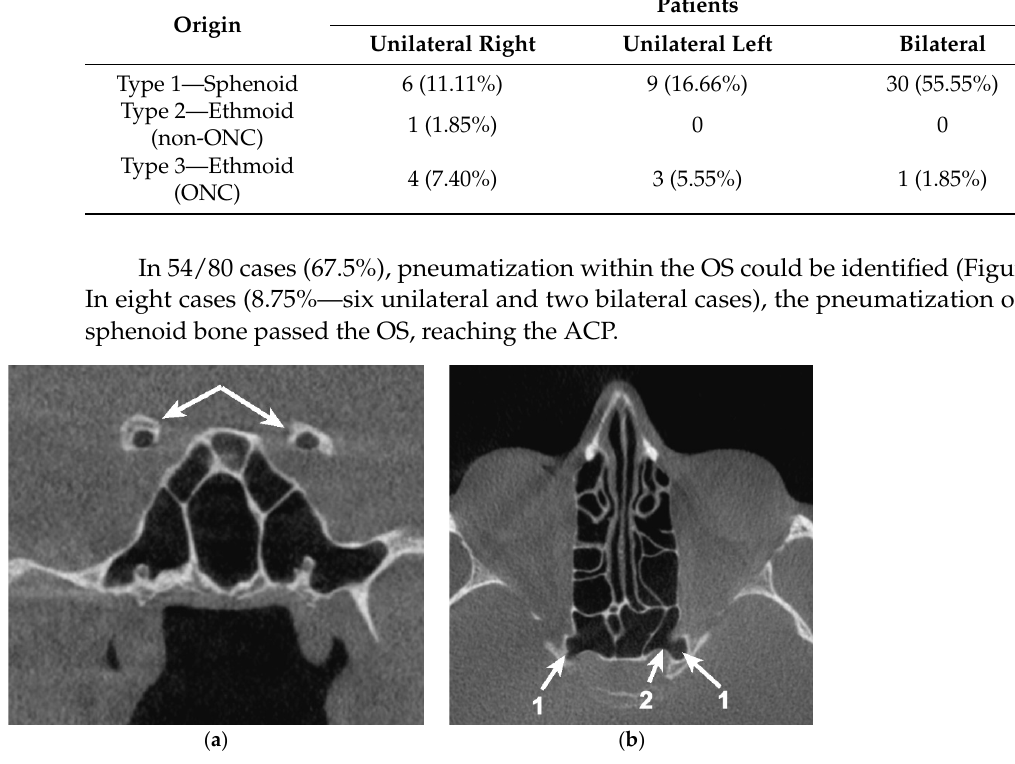
Figure 4. Bilateral sagittal CBCT reconstruction, demonstrating the pattern of pneumatization of both the optic strut and anterior root (AR) of the lesser sphenoidal wing. ( a ) Left side. ( b ) Right side: 1. Pneumatized AR; 2. Pneumatized OS; 3. Onodi cell; 4. Sphenoid sinus. 3. Onodi cell; 4. Sphenoid